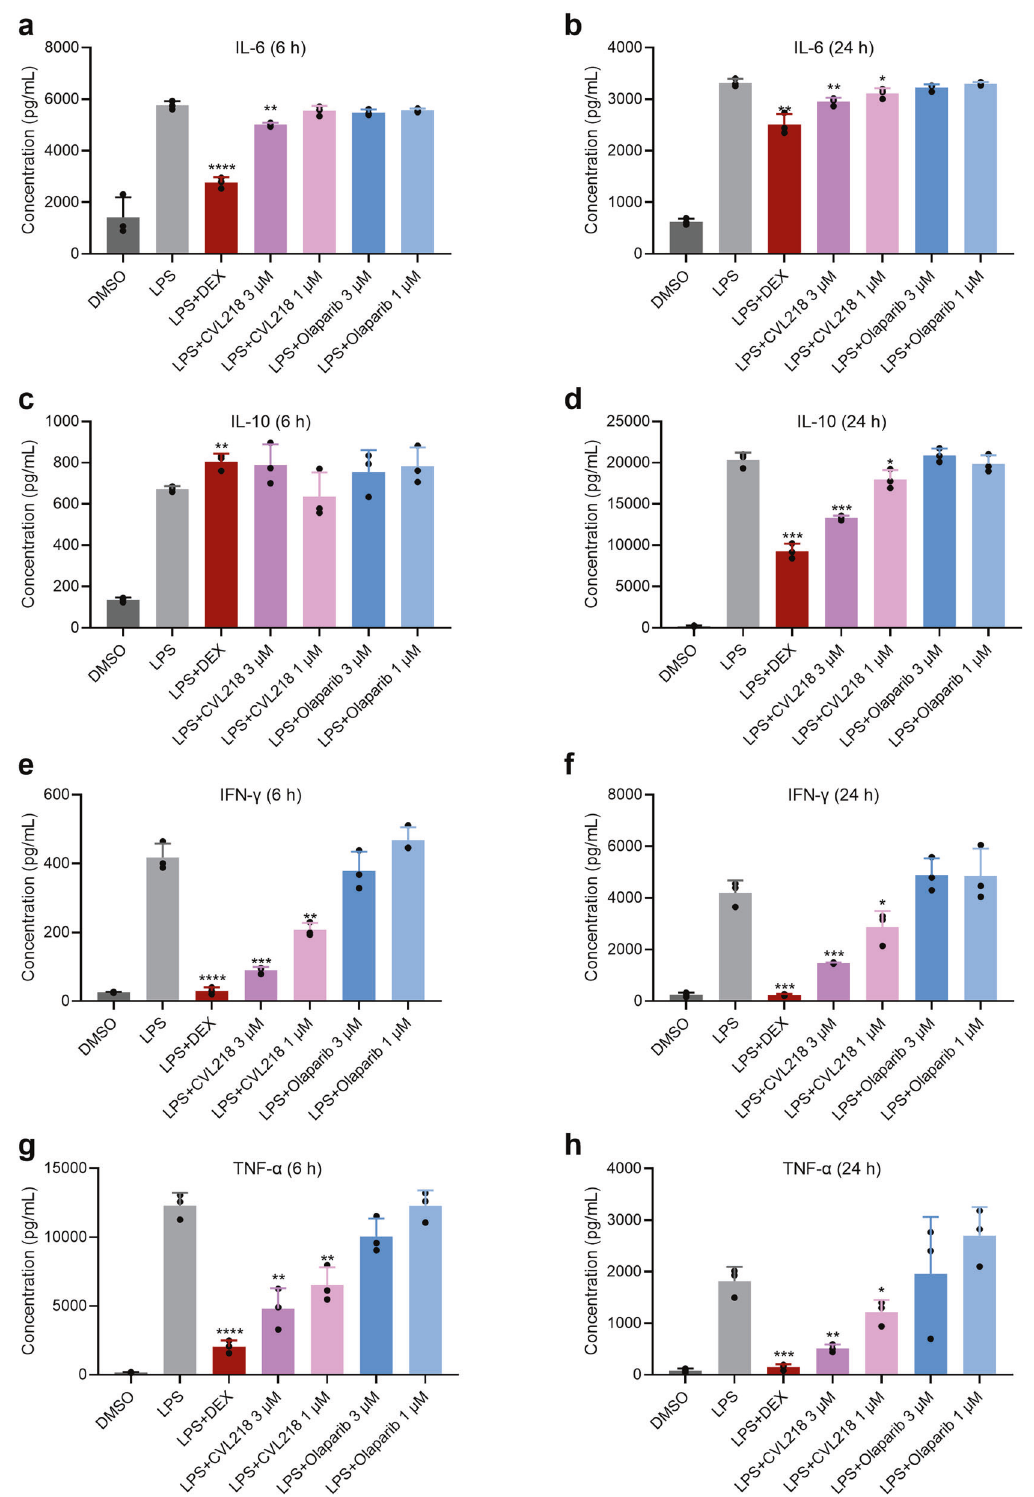
Fig. 4 CVL218 attenuates the LPS-induced cytokine production in a time- and dose-dependent manner. Concentrations of four cytokines (IL- 6, IL-10, IFN- γ , and TNF- α ) in the LPS-induced peripheral blood mononuclear cells (PMBCs) were measured by ELISA after 6 h and 24 h of drug treatment. Dexamethasone (DEX) in 1 μ g/mL was used as a positive control. a – h Concentrations of IL-6 after 6 h ( a ) and 12 h ( b ), IL-10 after 6 h ( c ) and 12 h ( d ), IFN- γ after 6 h ( e ) and 12 h ( f ), and TNF- α after 6 h ( g ) and 12 h ( h ) of drug treatment. Results are shown as mean ± SD over three replicates. The signi fi cances were measured by p -values from two- t ailed t -tests between LPS + drug and LPS only groups. *, **, ***, and **** stand for p -value < 0.05, 0.01, 0.001, 0.0001, respectively